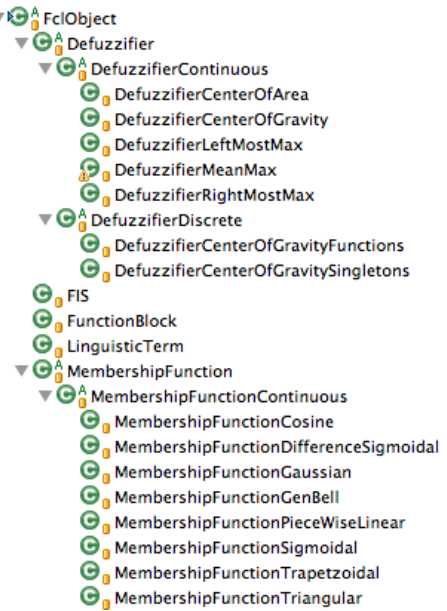
Fig. 5. Part of jFuzzyLogic’s object tree. Used to provide API extension